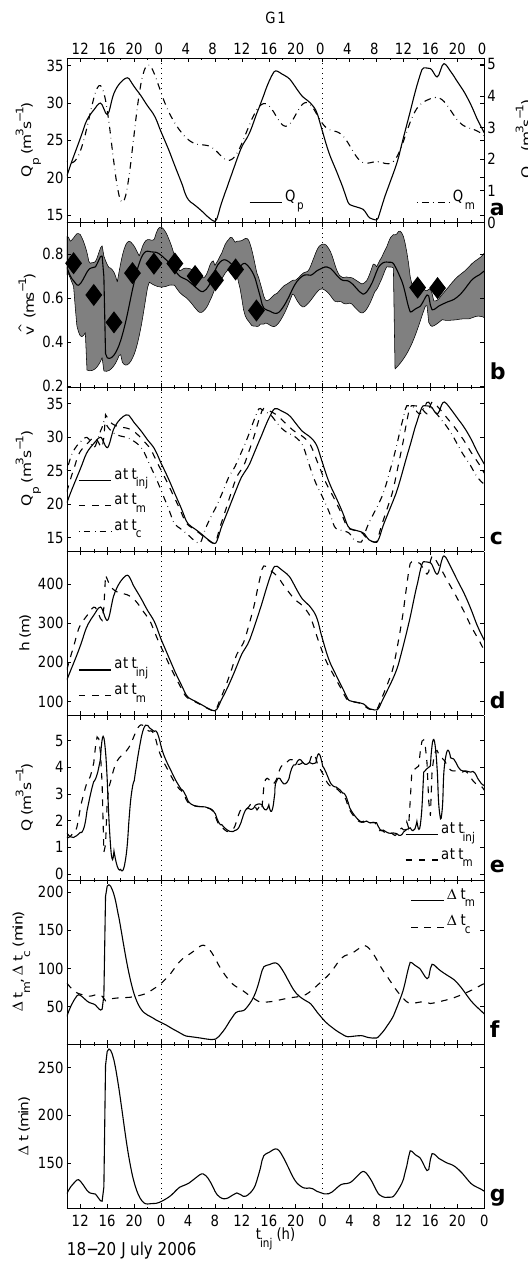
Fig. 5. Model inputs, outputs and comparison with measurements from fitting the model to all the transit speed data from the Gorner- gletscher experiments (model run G1). (a) Proglacial discharge Q p (left scale) and moulin input Q m (right scale); (b) measurements of transit speed are indicated by diamond symbols, the model output ˆ v by the solid line and the error bounds of ˆ v in grey; (c) proglacial dis- charge at injection time t inj (solid), at moulin exit time t m (dashed) and channel exit time t c (dashed-dotted); (d) hydraulic head h – line style as in (c); (e) discharge from the moulin Q – line style as in (c), the dotted line marks zero discharge; (f) moulin residence time 1t m (solid) and channel residence time 1t c (dashed); (g) total residence time 1t . The vertical dotted lines demarcate the